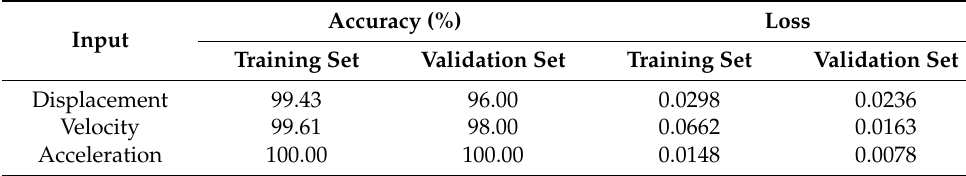
Figure 10. Results of vehicle speed identification: ( a ) Training accuracy curves of response samples; ( b ) Training loss curves of the response samples; ( c ) Validation accuracy curves of the response samples; ( d ) Validation loss curves of response samples. Table 5. Train results of vehicle speed identification after 50 epochs.